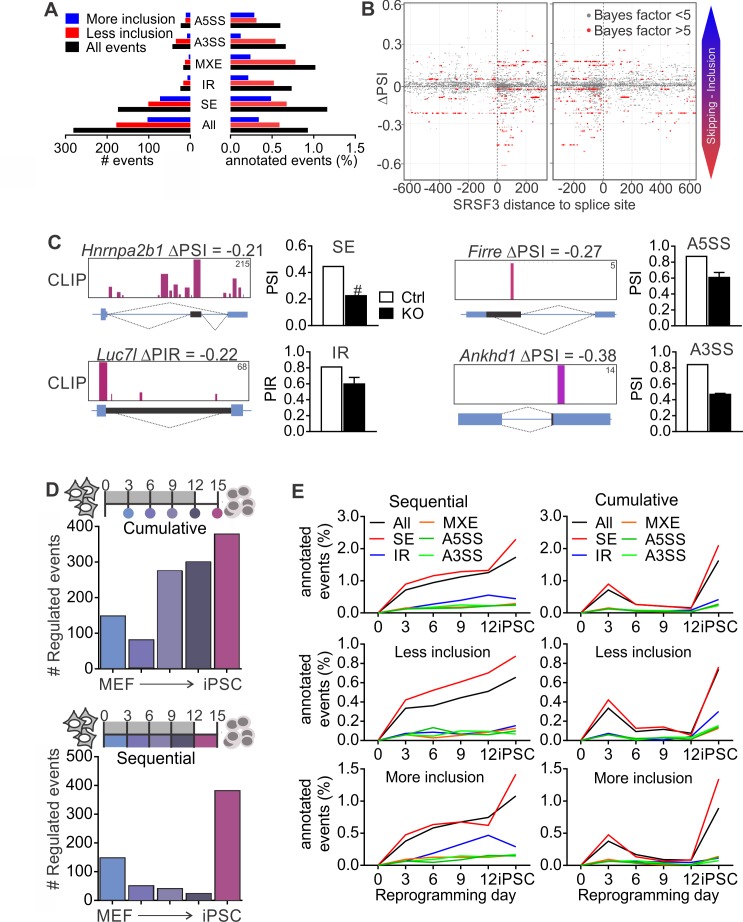
SRSF3 regulated alternative splicing in pluripotent cells and the dynamics of AS during reprogramming.(A) Different alternative splicing (AS) types affected by SRSF3 depletion in pluripotent cells. Pluripotent cells were subjected to RNA sequencing 24 hr following SRSF3 depletion and AS changes were quantified by MISO (ΔPSI ≥ |0.2| and Bayes factor ≥5). SE, skipped exon; IR, intron retention; MXE, mutually exclusive exon; A3SS, alternative 3’ slice site; A5SS, alternative 5’ splice site. (B) SRSF3 binding sites (iCLIP) at and around SE events that were annotated by MISO. The red dots represent AS events that were considered significantly changed following SRSF3 depletion (Bayes factor >5) and grey dots events that did not change (Bayes factor <5). The opacity of the dots corresponds to the log2(iCLIP count) in the range 1 to 5 before log transformation. Significant SRSF3-binding sites with iCLIP count ≥2 that were not detected in the control iCLIP are shown. The dotted lines at 0 denote the 3’ and 5’ splice sites. (C) Representative examples of different AS types affected by SRSF3 depletion. SRSF3-binding sites mapping at and around the affected event are shown over the gene diagram (PSI values based on MISO, data as mean ± SEM, n = 2). PSI, percent spliced in; PIR, percent intron retained. Ctrl, control cells; KO, SRSF3-depleted cells. (D) Dynamic AS changes take place during reprogramming (MISO, ΔPSI ≥ |0.2| and Bayes factor ≥5). Comparison of each time point to MEFs showing a cumulative increase in AS from MEFs to iPSC (top) and assessment of consecutive time points demonstrating that the majority of AS changes take place in only two time points (below). (E) Different AS types display distinct dynamics during reprogramming. Cumulative and sequential change as in D, event types as in A. See also Figure 5—figure supplement 1 and Figure 5—source data 1–3.10.7554/eLife.37419.016Figure 5—source data 1.Alternative splicing events following SRSF3 depletion.10.7554/eLife.37419.017Figure 5—source data 2.Alternative splicing events during reprogramming relative to MEFs.10.7554/eLife.37419.018Figure 5—source data 3.Alternative splicing events between consecutive time points during reprogramming.